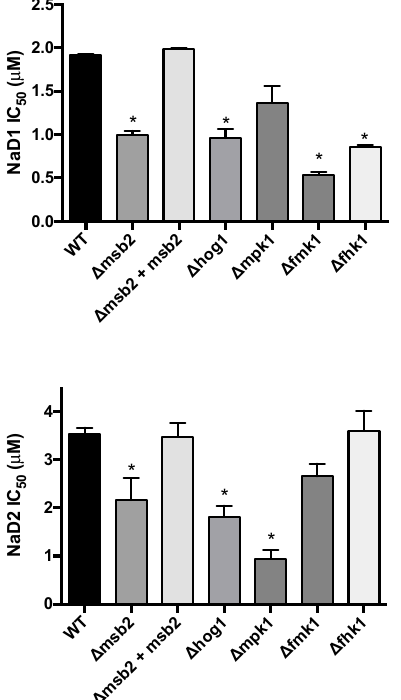
Figure 2. Concentrations of the plant defensins, NaD1 and NaD2, required to inhibit 50% growth (IC 50 ) of Fusarium oxysporum f. sp. lycopersici knock out mutants of the mitogen-activated protein kinase (MAPK) pathways. Error bars are SEM, NaD1 n = 3, NaD2 n = 6. * indicates data that is significantly different ( p < 0.05) to WT.